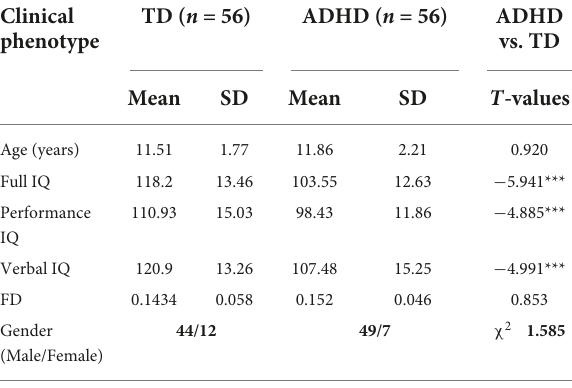
TABLE 1 Demographic and clinical characteristics of ADHD and TD control